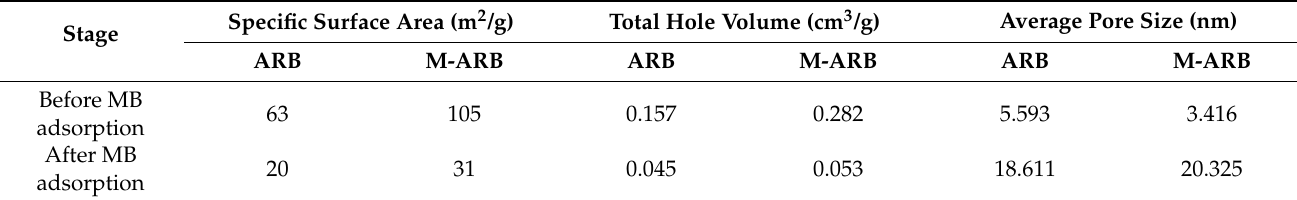
Table 6. Comparison of BET analysis results before and after adsorption of